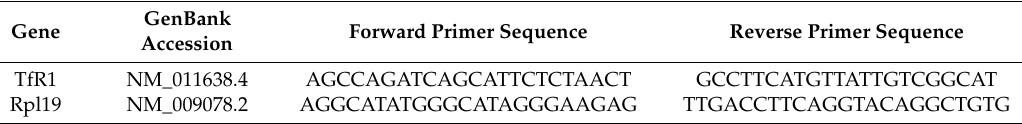
Table 1. List of gene-specific primers used for qPCR.